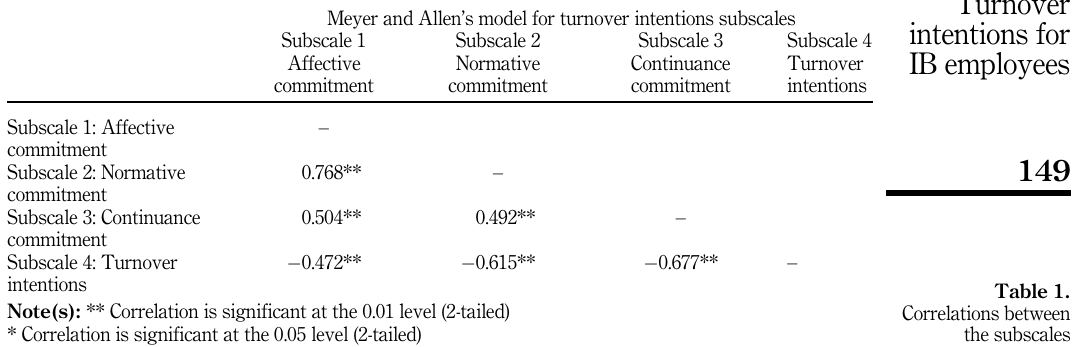
Table 1. Correlations between the subscales